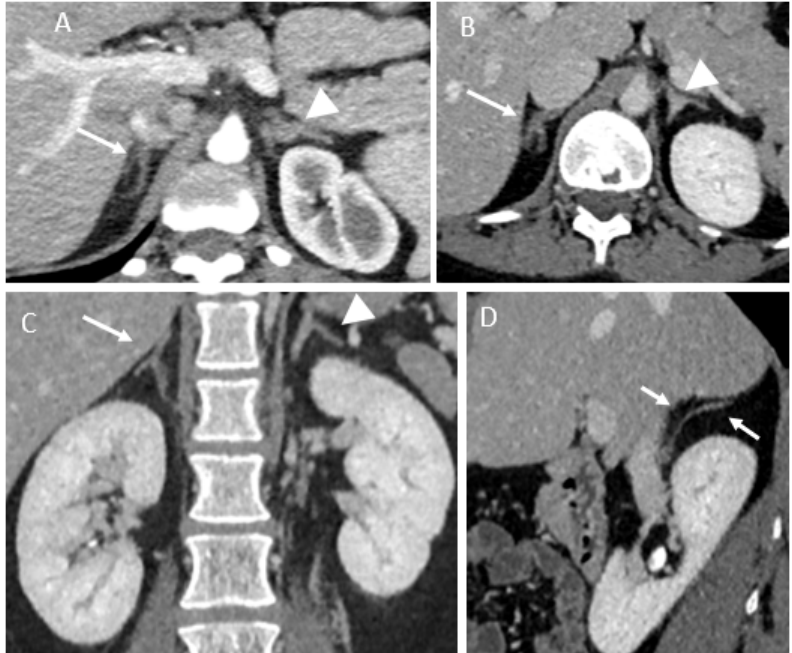
Figure 3. Follow-up imaging CT findings. ( A ) Patient 2, residual atrophy of the right adrenal gland (arrow). Normal appearance of the contralateral adrenal gland (arrowhead). ( B ) Patient 1, contrast-enhanced CT showing partial enhancement of the right adrenal gland (arrow). Normal appearance of the contralateral adrenal gland (arrowhead). ( C , D ) Patient 3, coronal and sagittal view of contrast-enhanced CT showing atrophy of the lateral arm of the right adrenal gland (arrow). Normal appearance of the contralateral adrenal gland (arrowhead).